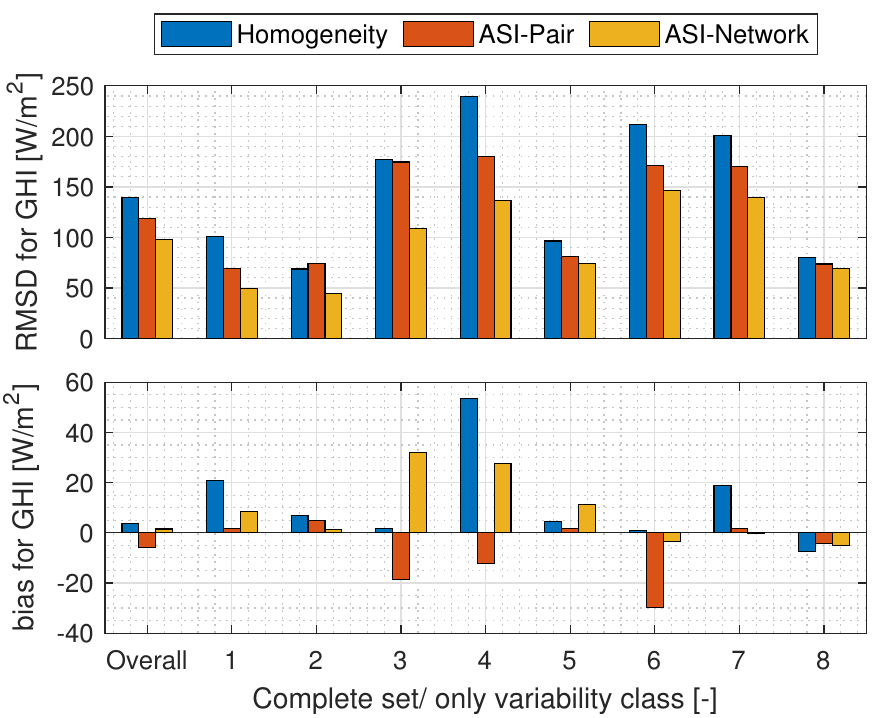
Figure 11. This figure shows the deviation metrics RMSD and bias for the tested approaches to analyze GHI (homogeneous persistence, blue; ASI pair, red; and ASI network, yellow). The evaluation for GHI is based on the 28 day validation dataset (labeled overall ) and for eight subsets distinguished by the DNI variability